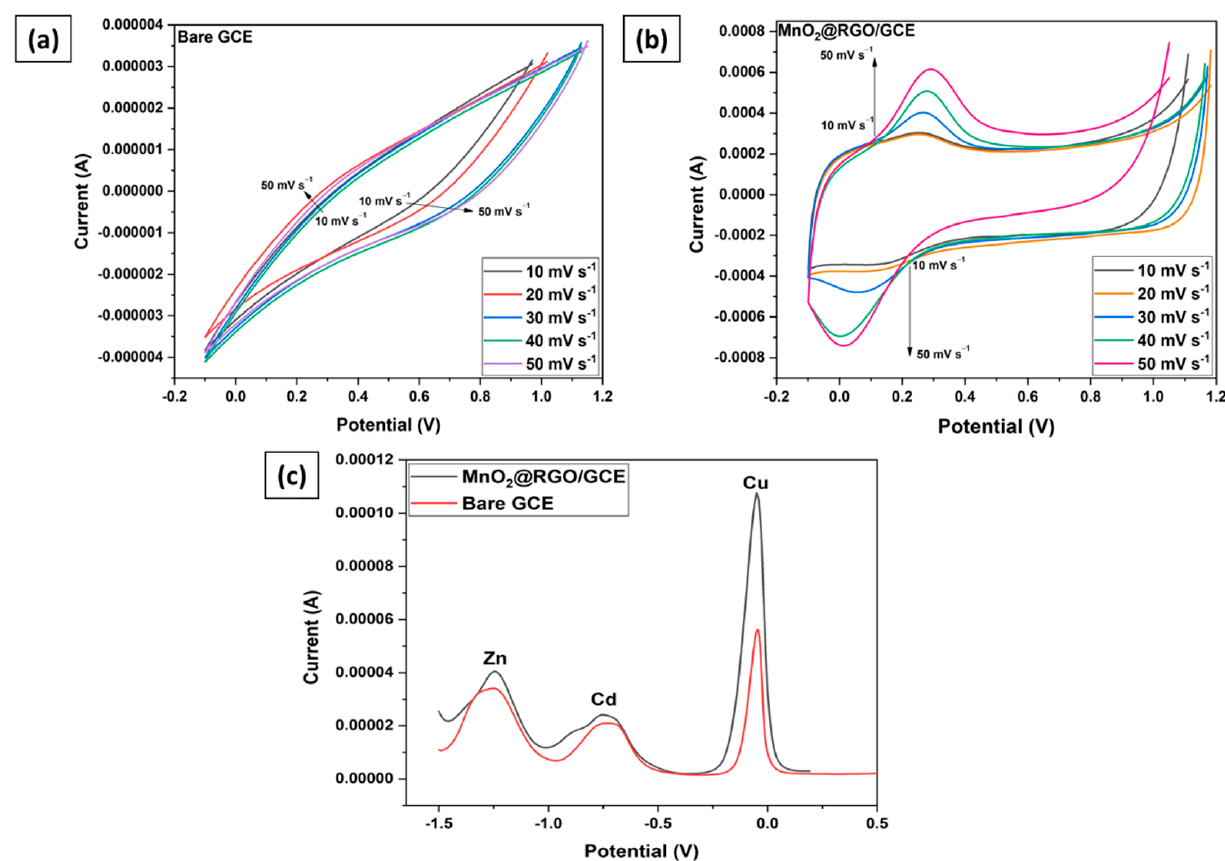
Figure 6. Cyclic voltammograms at different scan rates for ( a ) Bare GC electrode, ( b ) MnO 2 @RGO nanocomposite modified GCE; Differential pulse voltammograms for the detection of Cu(II), Cd(II), Zn(II) using bare GCE and MnO 2 @RGO nanocomposite modified GCE ( c ).